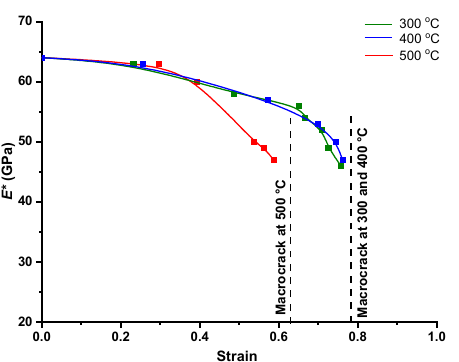
ε Figure 11. The strain ( ) dependence of the reduced elastic modulus E * for the V95\10% SiC MMC Figure 11. The strain ( ε ) dependence of the reduced elastic modulus E * for the V95 \ 10% SiC MMC specimen at 300, 400 and 500 ° С , the dependence being valid for the zone near the side surface of specimen at 300, 400 and 500 ◦ C, the dependence being valid for the zone near the side surface of the the specimen (see Figure 2). specimen (see Figure